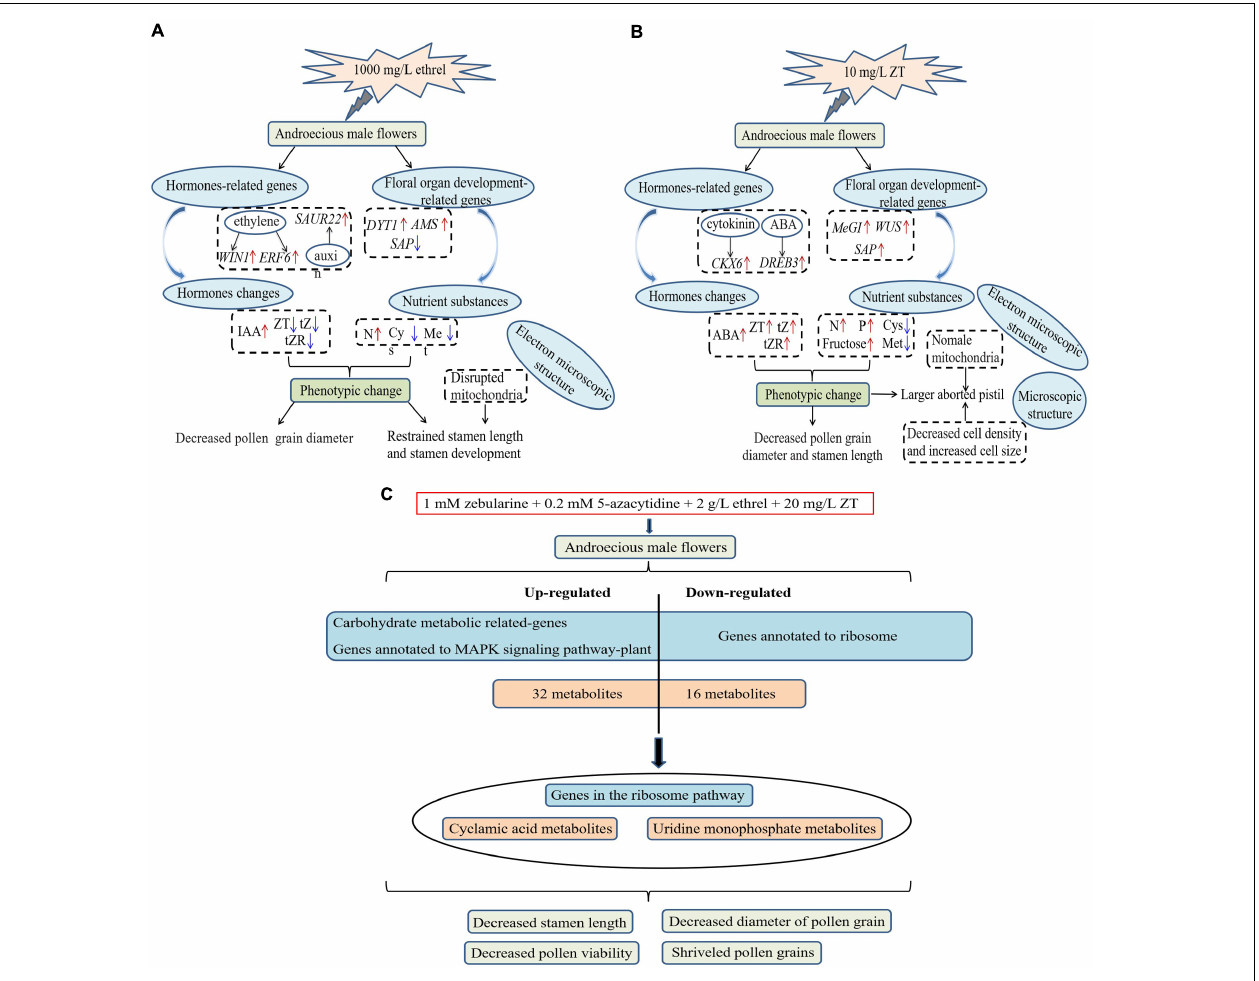
FIGURE 11 | Proposed regulatory networks activated in persimmon flowers in response to exogenous chemicals. (A) Treatment with 1000 mg/L ethrel. (B) Treatment with 10 mg/L ZT. (C) Combined treatment with zebularine, 5-azacytidine, ethrel, and ZT. Expression levels are shown using a color gradient from low (blue) to high